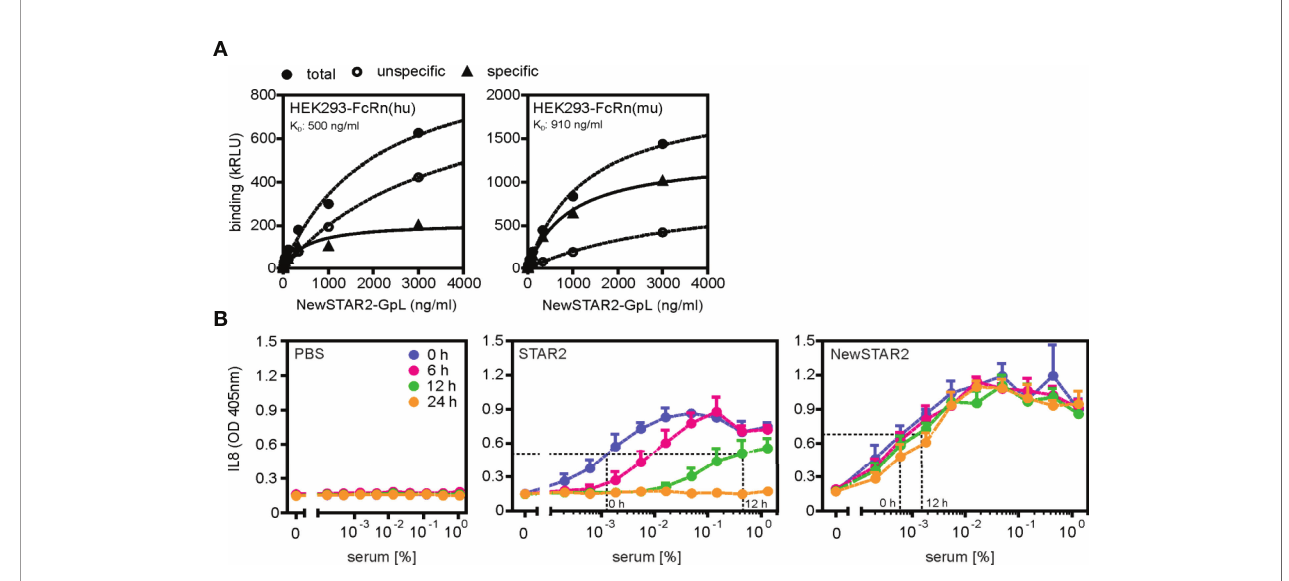
FIGURE 3 | NewSTAR2 has a superior bioavailability. (A) Speci fi c binding of a GpL fusion protein of NewSTAR2 to cells expressing the human or murine neonatal Fc receptor(FcRn). (B) Mice (3per group) were injected i.v.with 50 m g STAR2 or 75 m g NewSTAR2 orPBS. Blood was taken at indicated time points after treatment, diluted as indicated andusedto stimulateHT1080-Bcl2-TNFR2 cells. IL-8 inthe supernatant was determined the next day to quantify TNFR2 engagement. The dashedy-lines show the level of half-maximal IL8induction to facilitate identi fi cation ofEC 50